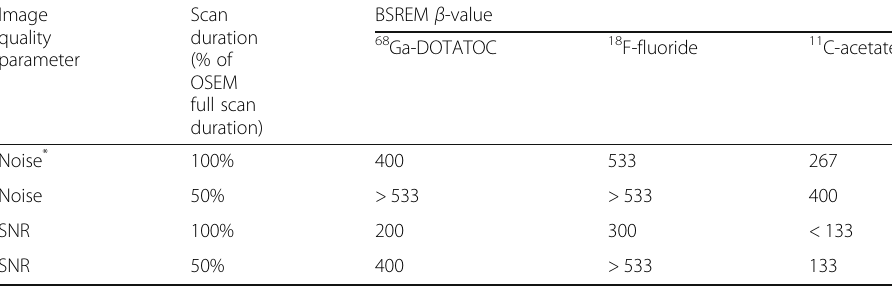
Table 2 Summary of BSREM β -values that resulted in similar image quality measure, either noise